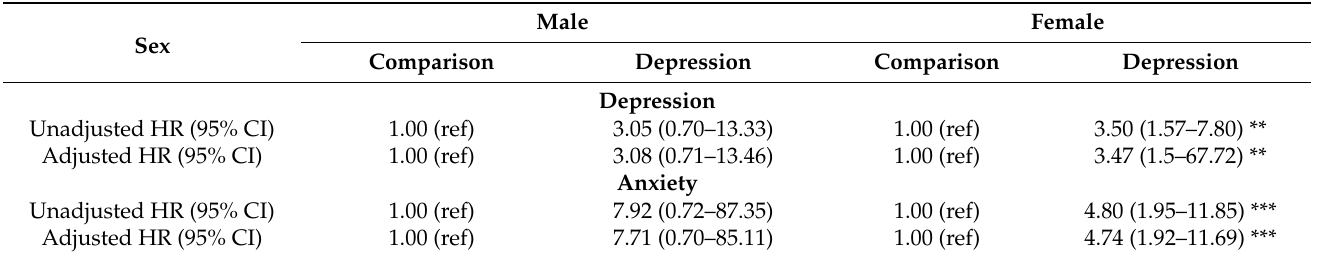
Table 6. Hazard ratios of incident burning mouth syndrome by sex in patients with depression or